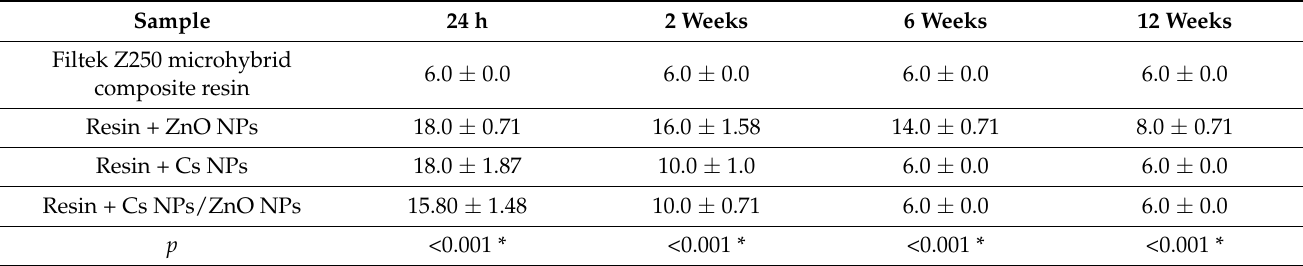
Table 5. Width of the inhibition zone against S. mutans ,